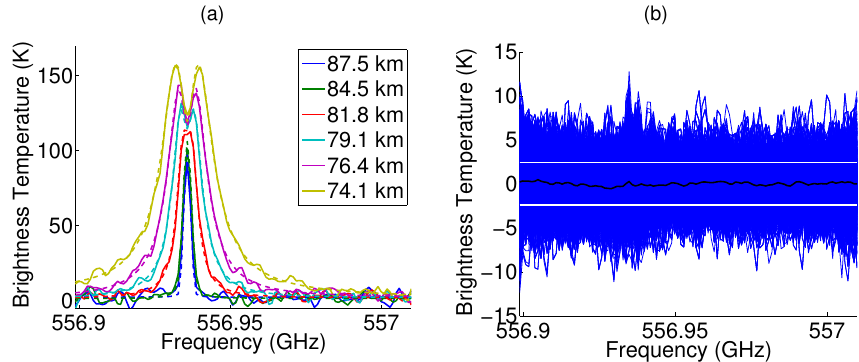
Figure 6. (a) Sample spectra of the 557GHz line from orbit 51226 at different heights (solid lines), with fitted spectra (dashed lines). (b) Residuals of all spectra in orbit 51226 (blue), mean of the residuals in that orbit (black) and the average (1 σ ) thermal noise of the measurements